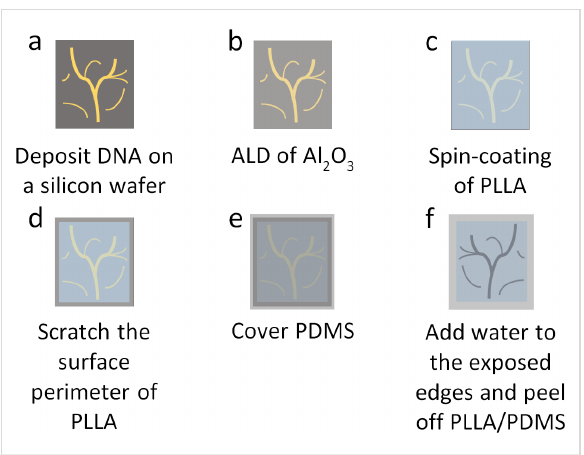
Figure 1: Fabrication process of a polymer stamp using a DNA nano- structure master template with a protective Al 2 O 3 film. (a) DNA nano- structures are deposited on a silicon wafer. (b) The silicon wafer is coated with Al 2 O 3 by atomic layer deposition. (c) A polymer film (e.g., PLLA) is spin-coated onto the silicon wafer. (d) The edges of the polymer film is scraped off with a blade. (e) A PDMS film is adhered to the polymer film as a backing support. (f) Droplets of water are added to the exposed edges of the silicon wafer and the PLLA/PDMS film is peeled